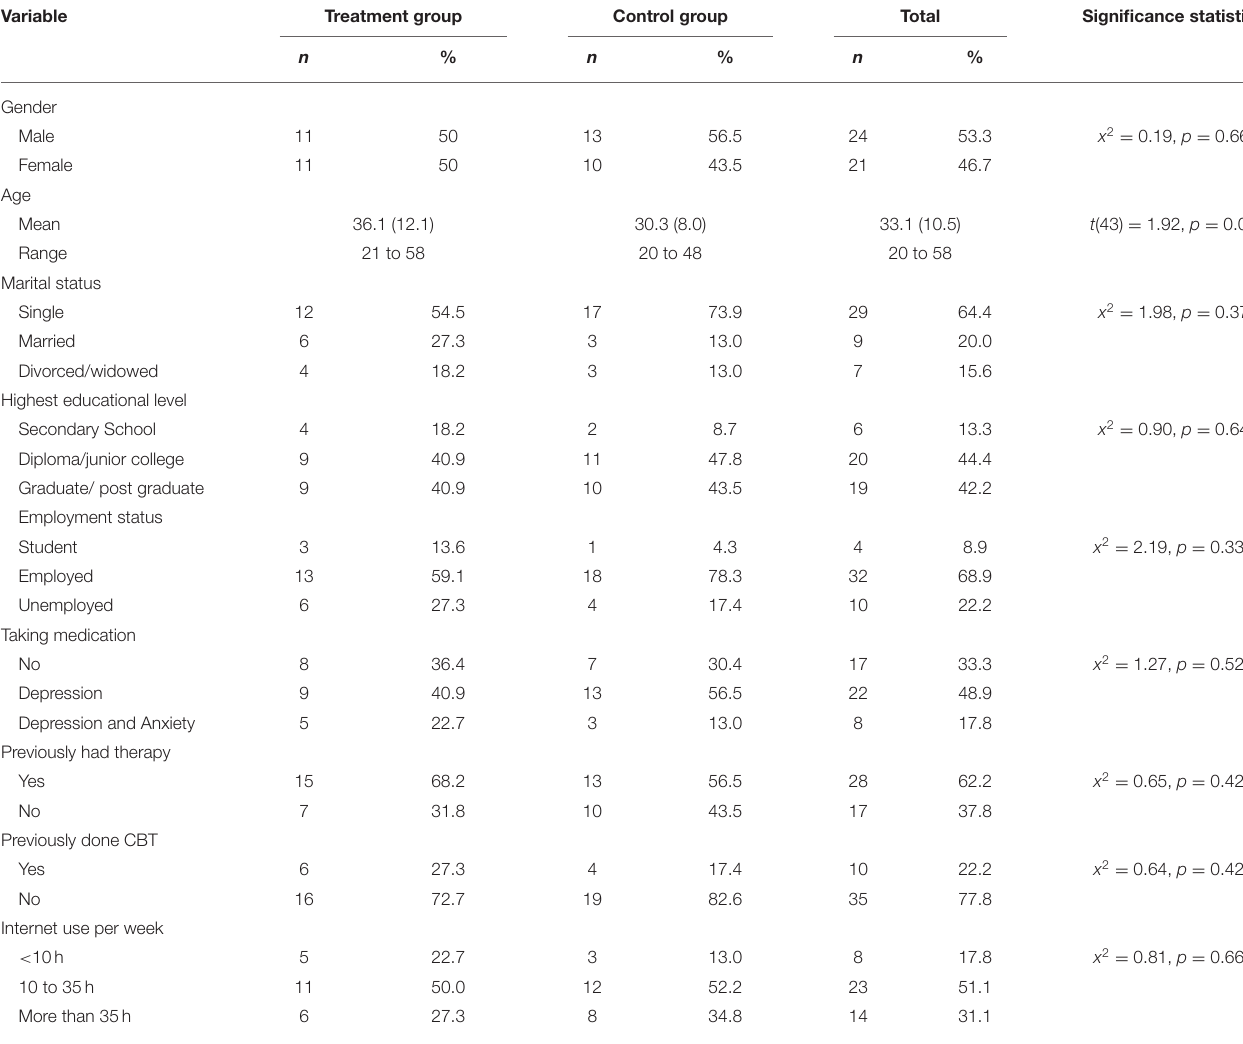
TABLE 1 | Demographic characteristics of the